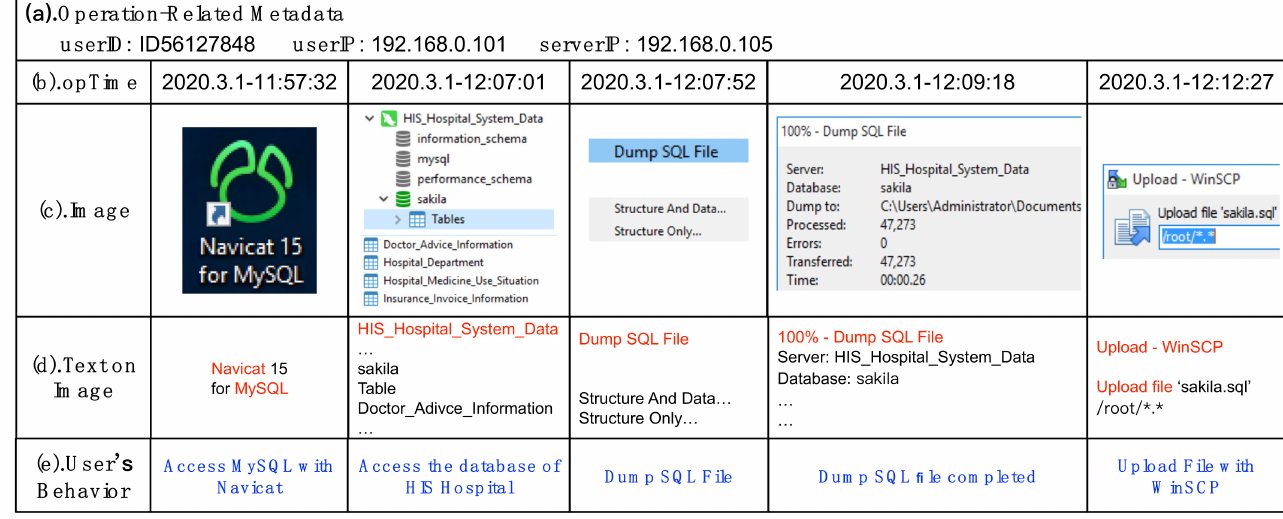
Figure 4. An actual case of privileged user behavior audit. A privileged user tried to dump the database file and send it to the remote